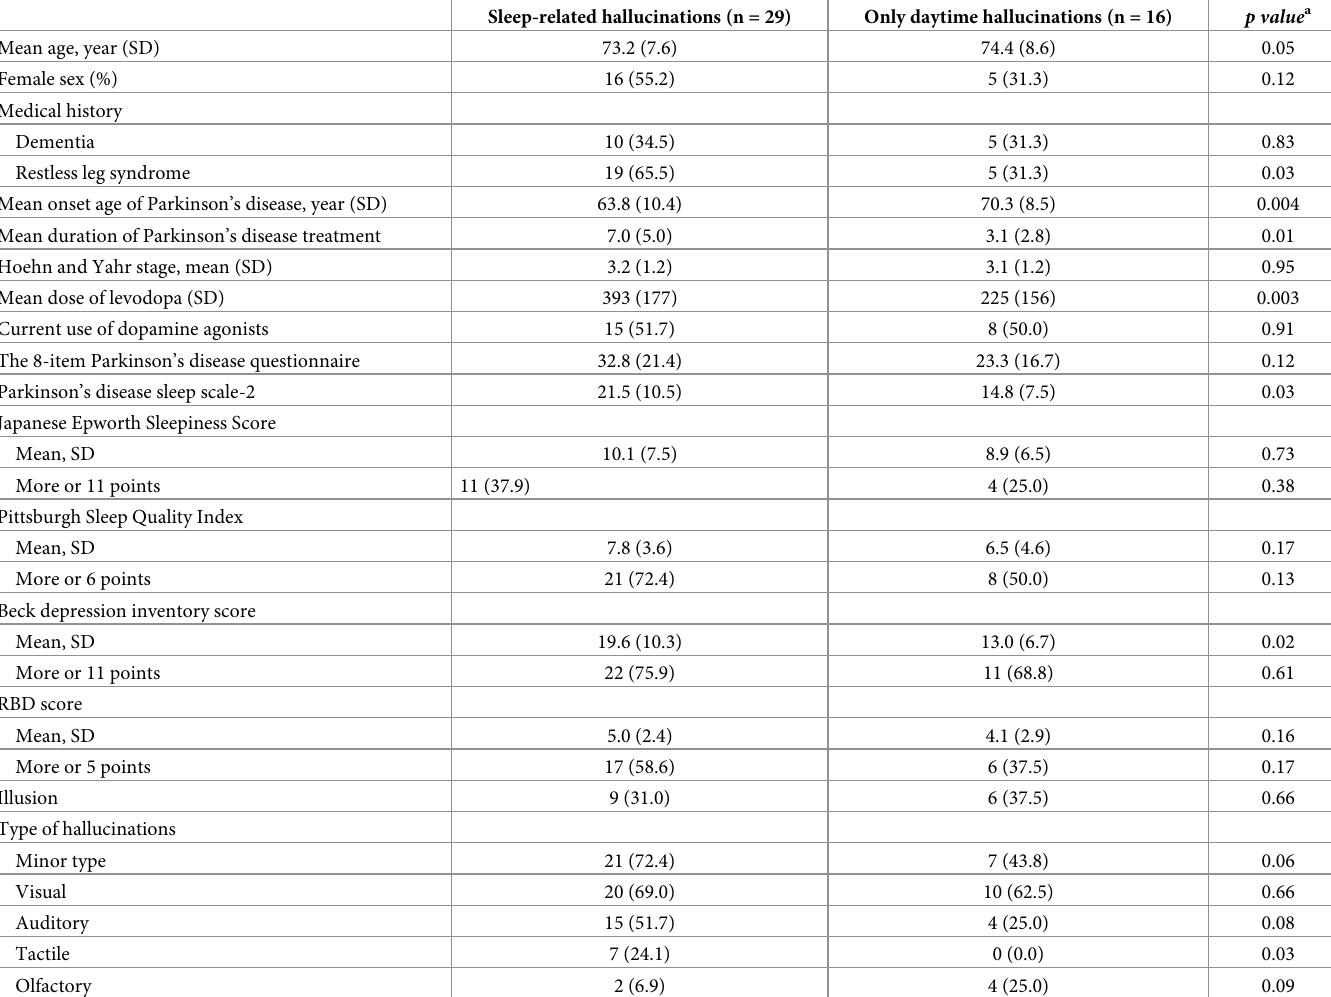
Table 4. Comparison of characteristics between Parkinson’s disease patients with sleep-related hallucinations and those with only daytime